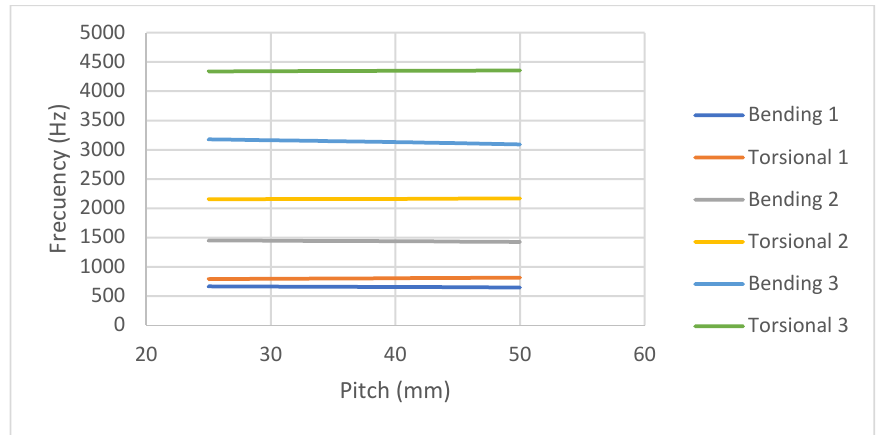
Figure 11. Sensitivity of the first resonance modes to the pitch of the helix.